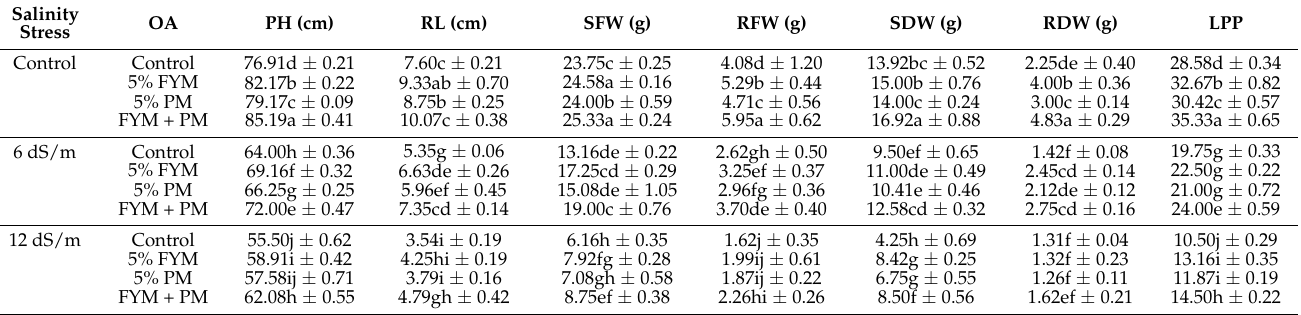
Table 1. Effect of different organic amendments on the rice growth traits under diverse salt stress